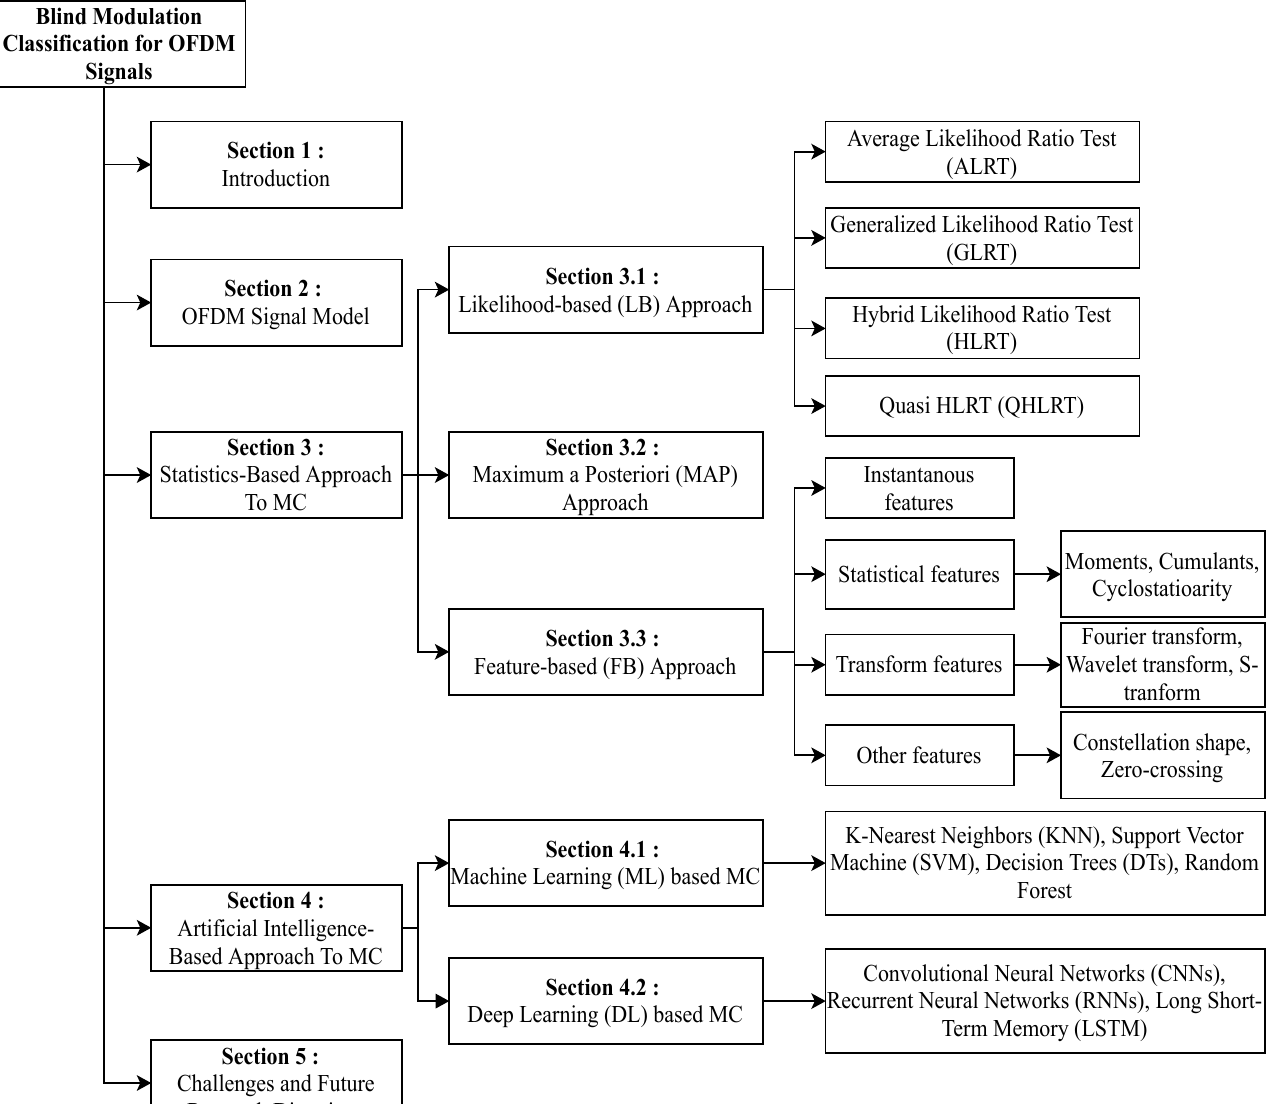
Figure 1. The organization of the